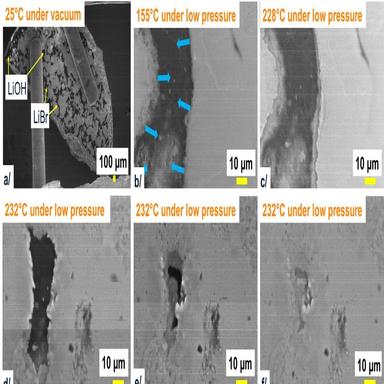
a/ Pellet of 3LiOH·LiBr where LiBr corresponds to the white areas and LiOH to the dark ones. b/−f/ Zoom in on the LiBr/LiOH/LiBr interfaces and layer-by-layer covering process visualisation (blue arrows).